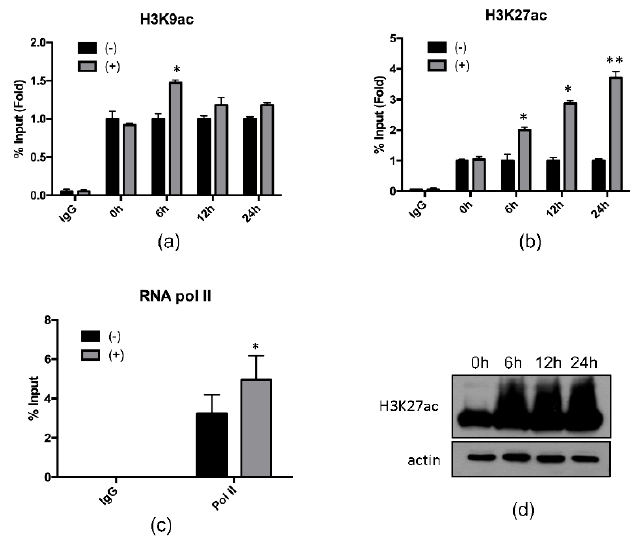
Figure 3. 4-PBA upregulated hepcidin transcription through hepcidin locus acetylation. Hepcidin locus acetylation in Huh 7.5-Con1 cells treated with 4-PBA for the indicated times was analyzed by ChIP. Nonspecific IgG was used as a negative control in immunoprecipitation and subjected to